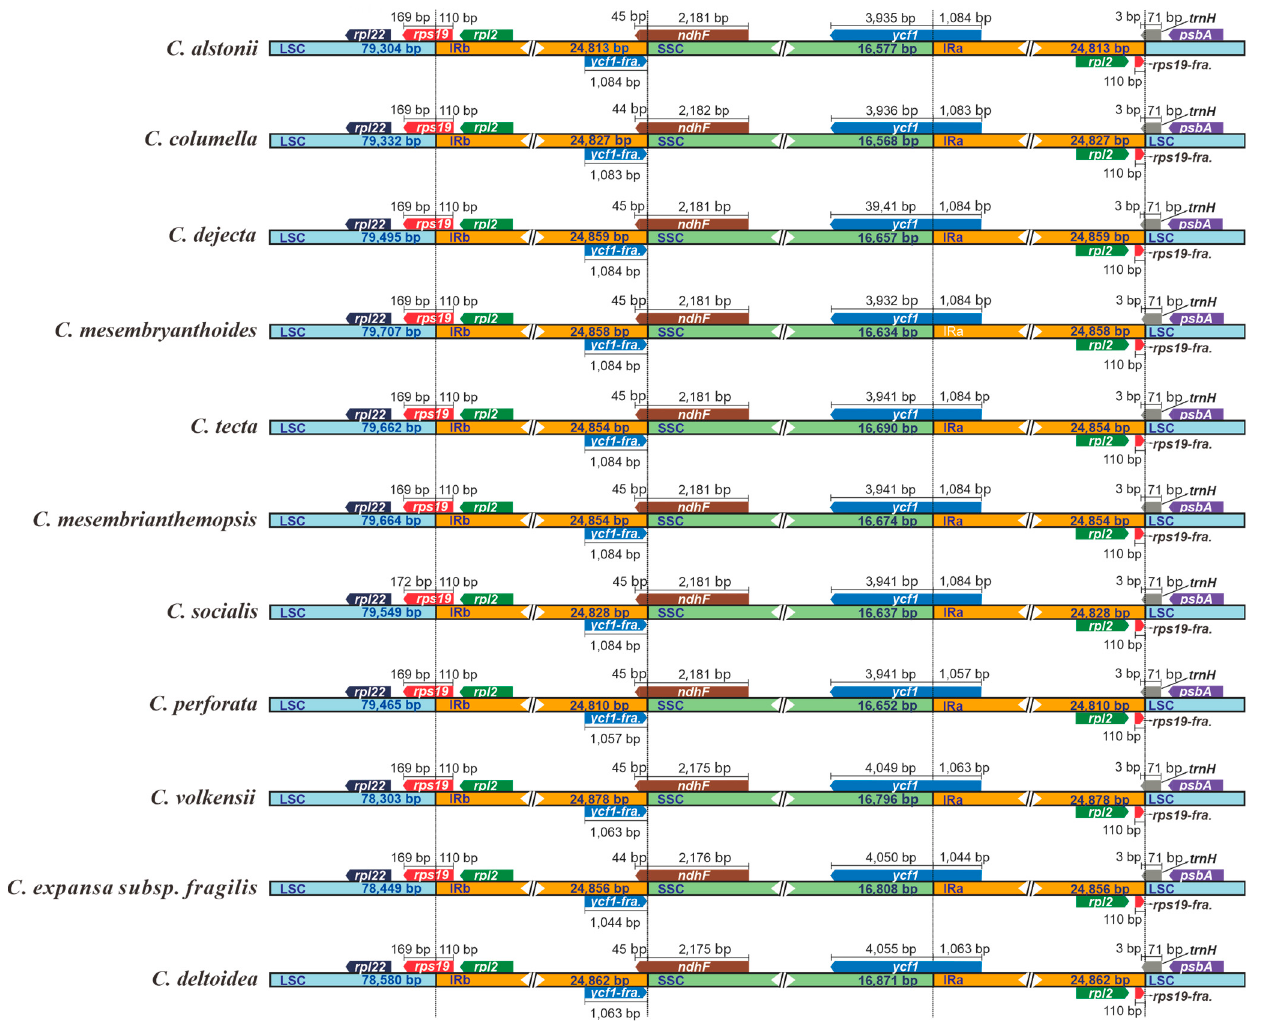
Figure 4. Comparisons of LSC, SSC, and IR region borders among plastomes of 11 Crassula species. Blue, orange and green blocks represent the LSC, IR and SSC regions, respectively. Gene boxes represented above the block were transcribed clockwise and those represented below the block were transcribed clockwise. “fra.” is the abbreviation of “fragment”.